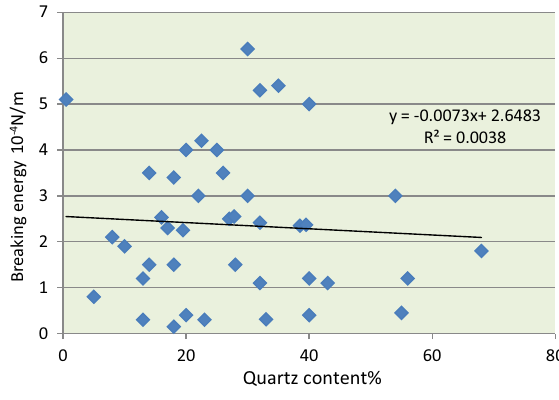
Fig. 7 Relationship between breaking energy and quartz content